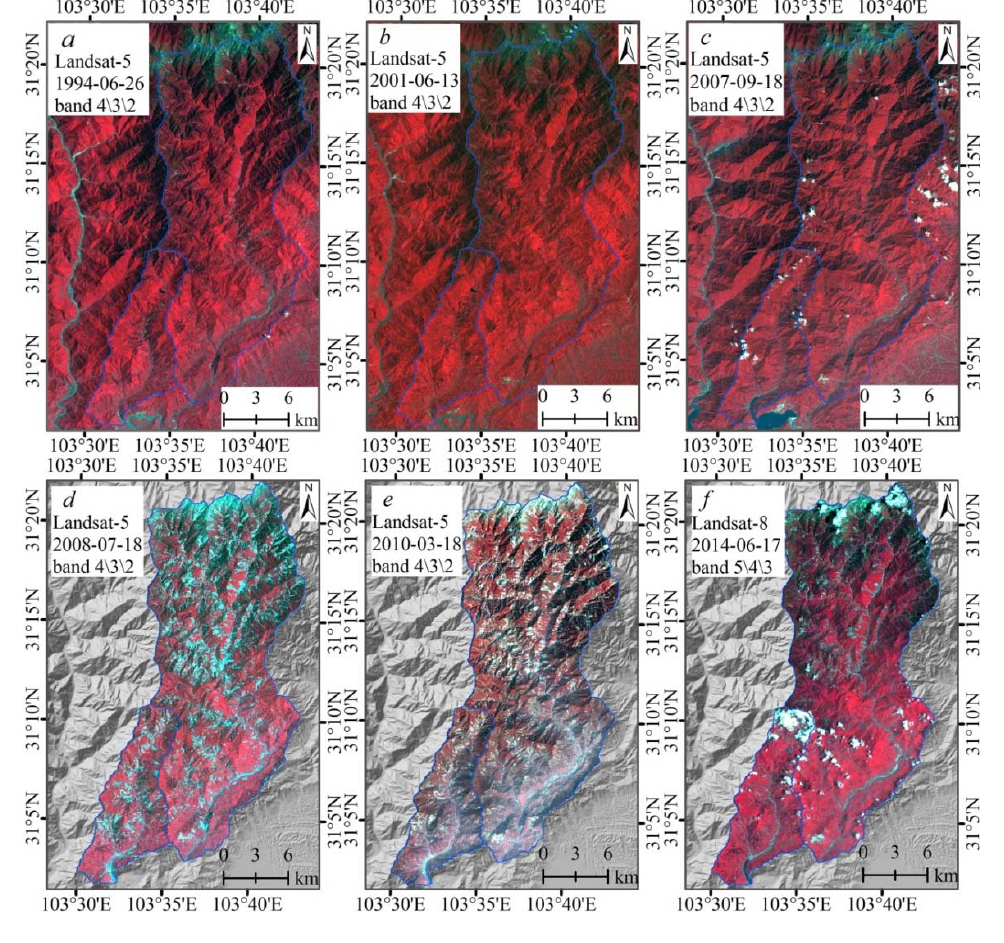
Figure 2. Multi-temporal Landsat-5/8 images at the study area ( a ) 26 June 1994 Landsat-5 image; ( b ) 13 June 2001 Landsat-5 image; ( c ) 18 September 2007Landsat-5 image; ( d ) 18 July 2008Landsat-5 image; ( e ) 18 March 2010Landsat-5 image; ( f ) 17 June 2014 Landsat-8